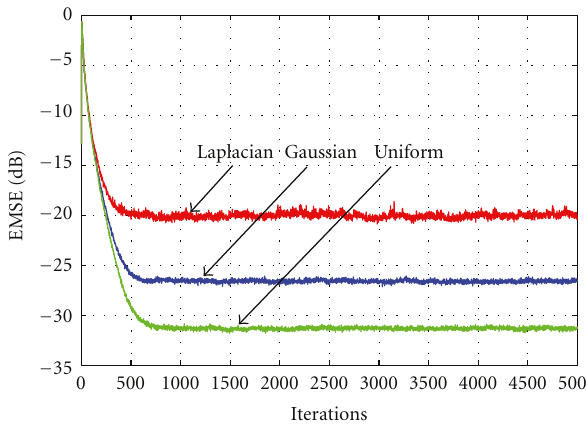
Figure 7: Learning curves of the proposed algorithm in di ff erent noise environments scenarios for α = 0 . 2 and SNR of 10dB.